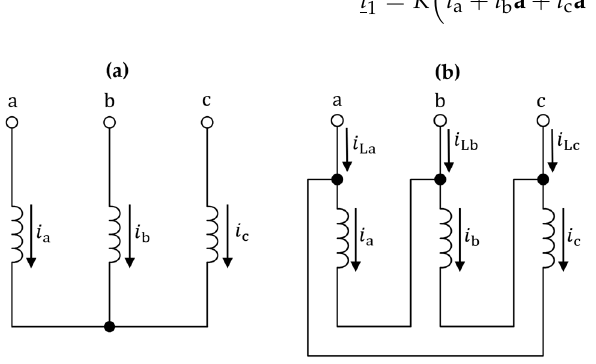
Figure 1. Three-phase winding: ( a ) star connection; ( b ) delta connection.